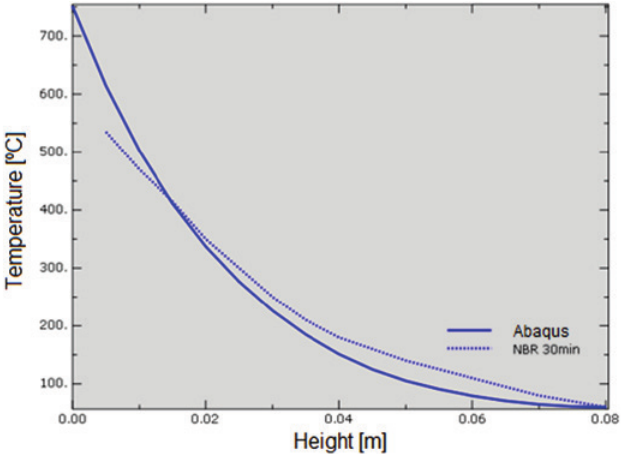
Temperature as function of the slab